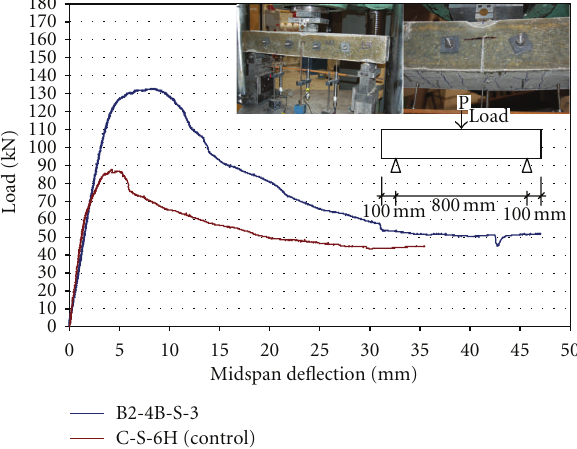
Figure 25: Load versus midspan deflection of RC beam B2-4B-NS- 3.